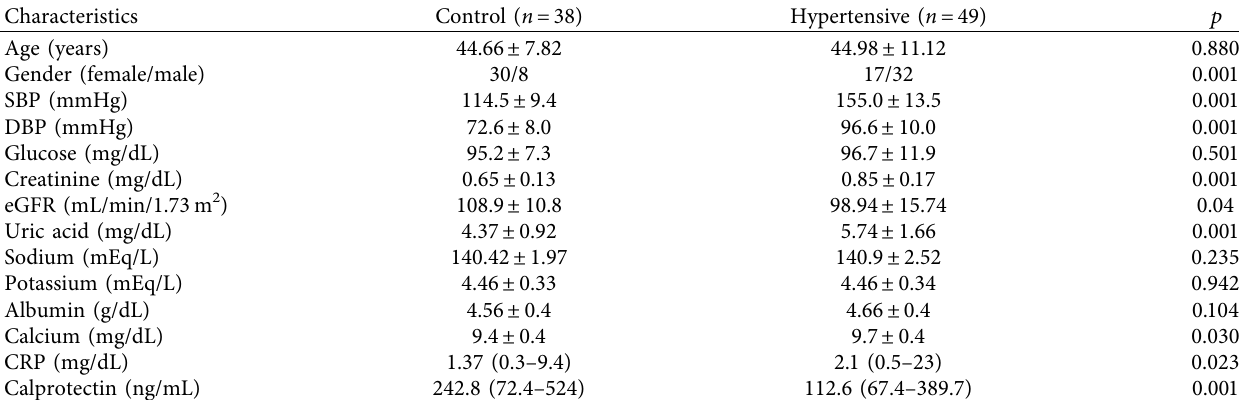
Table 1: Baseline characteristics and laboratory findings of the study population.